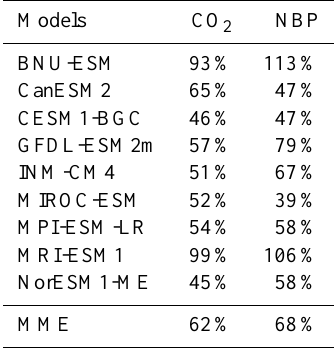
Table 4. Column atmospheric CO 2 and NBP amplitude (computed by CCGCRV, slightly different from max minus min) Increases of nine models by 2081–2090 relative to their 1961–1970 values and their multi-model ensemble